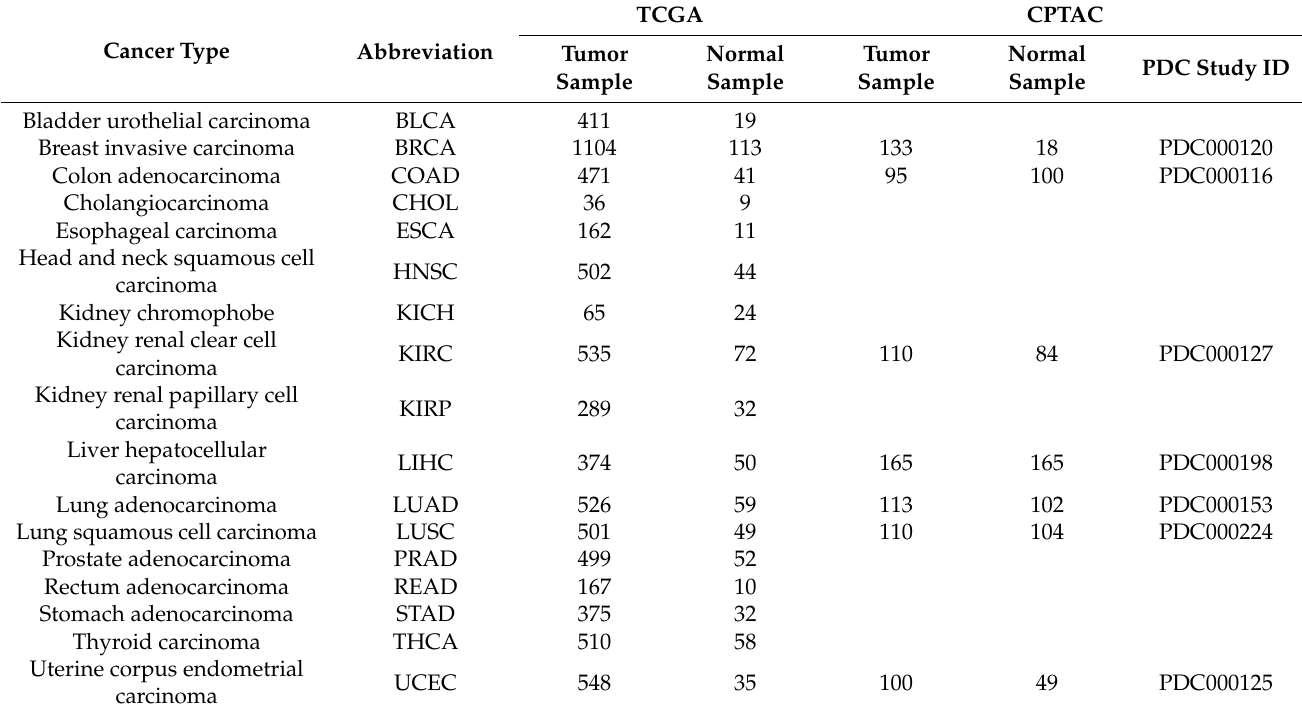
Table 1. The numbers of tumor and normal samples used in the